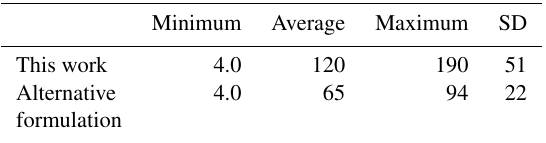
Table 4. This work versus alternative formulation of the gridded map uncertainty at annual timescales. Minimum, average, maxi- mum, and standard deviation (SD) of three-component 2 σ uncer- tainty for populated and FFCO2-emitting grid spaces. All values in percent. See text for parameters of the alternative